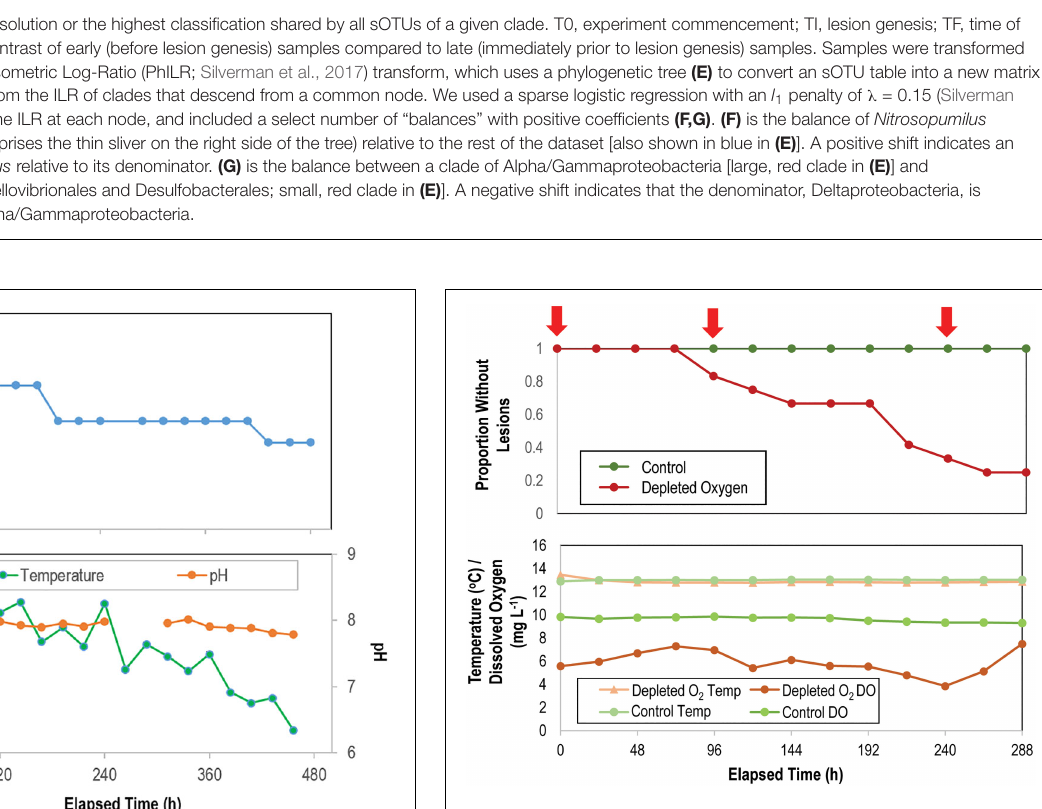
FIGURE 6 | Proportion of grossly normal P. ochraceus ( n = 6) remaining over time during longitudinal study of microbiome composition in the absence of external stimuli. The mean flow rate into aquariums was 3.81 ± 0.05 mL s − 1 (average residence time in aquariums 37 min). The panel below shows temperature and pH during the experimental period.